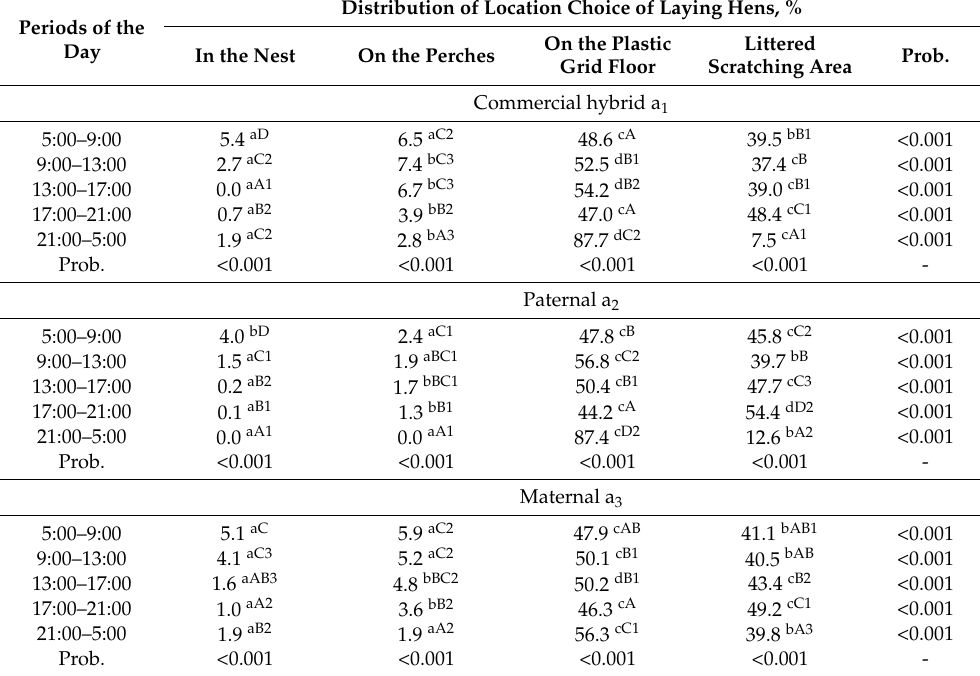
Table 2. Percentual distribution of laying hens among different parts of the pen depending on genotype and time of day